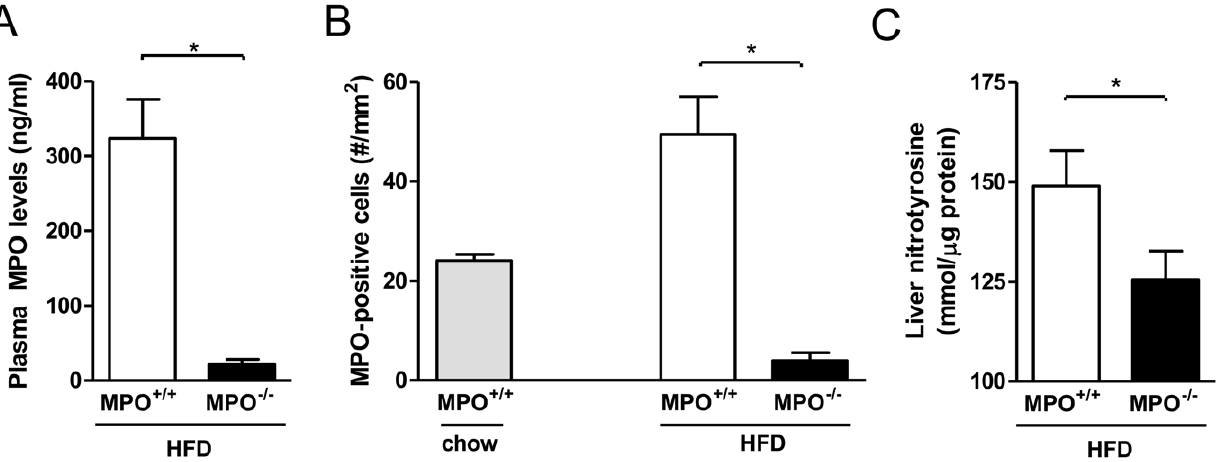
Figure 2. Reduced hepatic MPO and MPO-derived nitrated proteins in LDLR 2 / 2 / MPO 2 / 2 tp mice after 8 weeks of high-fat feeding. A) Plasma MPO levels of LDLR 2 / 2 / MPO 2 / 2 tp and LDLR 2 / 2 / MPO + / + tp mice (22 6 7 vs. 324 6 52 ng/ml, p , 0.01). B) The MPO-positive cell number is strongly reduced in the liver of LDLR 2 / 2 / MPO 2 / 2 tp vs. LDLR 2 / 2 / MPO + / + tp mice (49.5 6 7.6 vs. 4.0 6 1.6 cells/mm 2 , p , 0.01), and much lower than those observed in LDLR 2 / 2 / MPO + / + mice on chow. C) Hepatic levels of nitrotyrosine, a marker of MPO activity, are reduced in LDLR 2 / 2 / MPO 2 / 2 tp animals in comparison with LDLR 2 / 2 / MPO + / + tp mice (126 6 7 vs. 149 6 9 mmol/ m g protein, p=0.02).